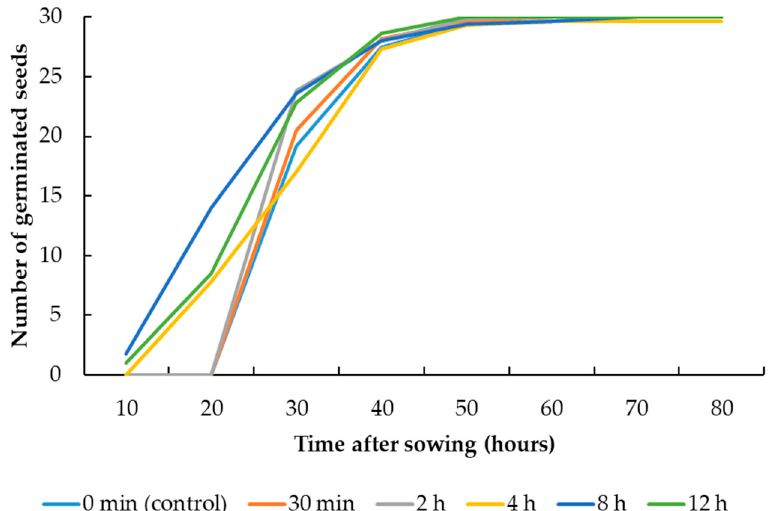
Figure 1. Cumulative seed germination of maize affected by the UV-C radiation treatments.